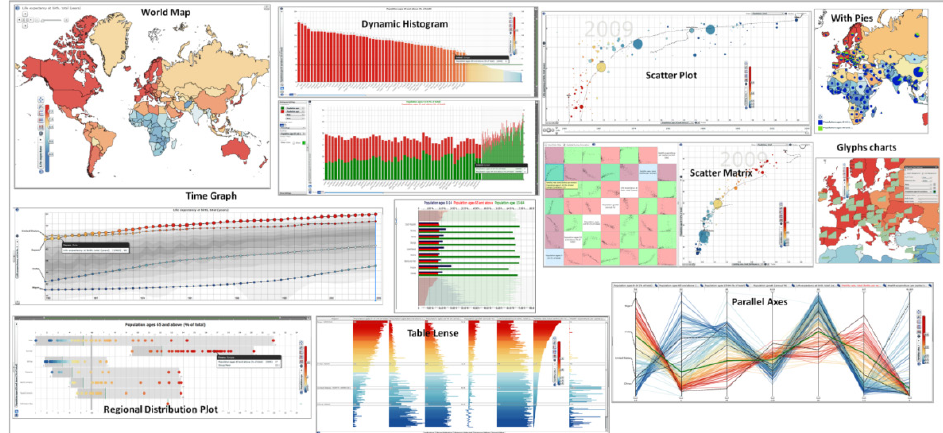
Figure 3. Different methods used with the platform’s information and geographical visualization